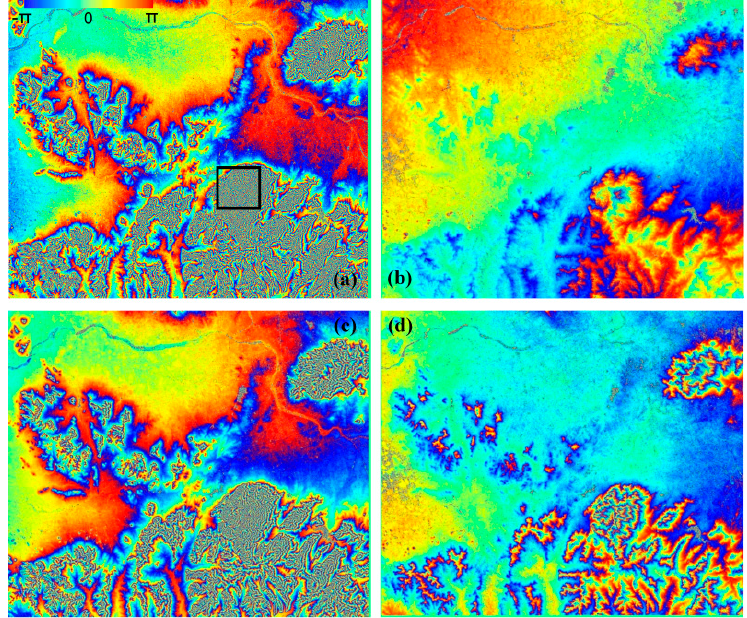
Figure 8. Flattened interferograms of the ALOS/PALSAR data. ( a ) Interferogram I, B ( b ) Interferogram II, B ⊥ = 77 m; ( c ) Interferogram III, B ⊥ = − 561 m; ( d ) Interferogram IV, B ⊥ = 185